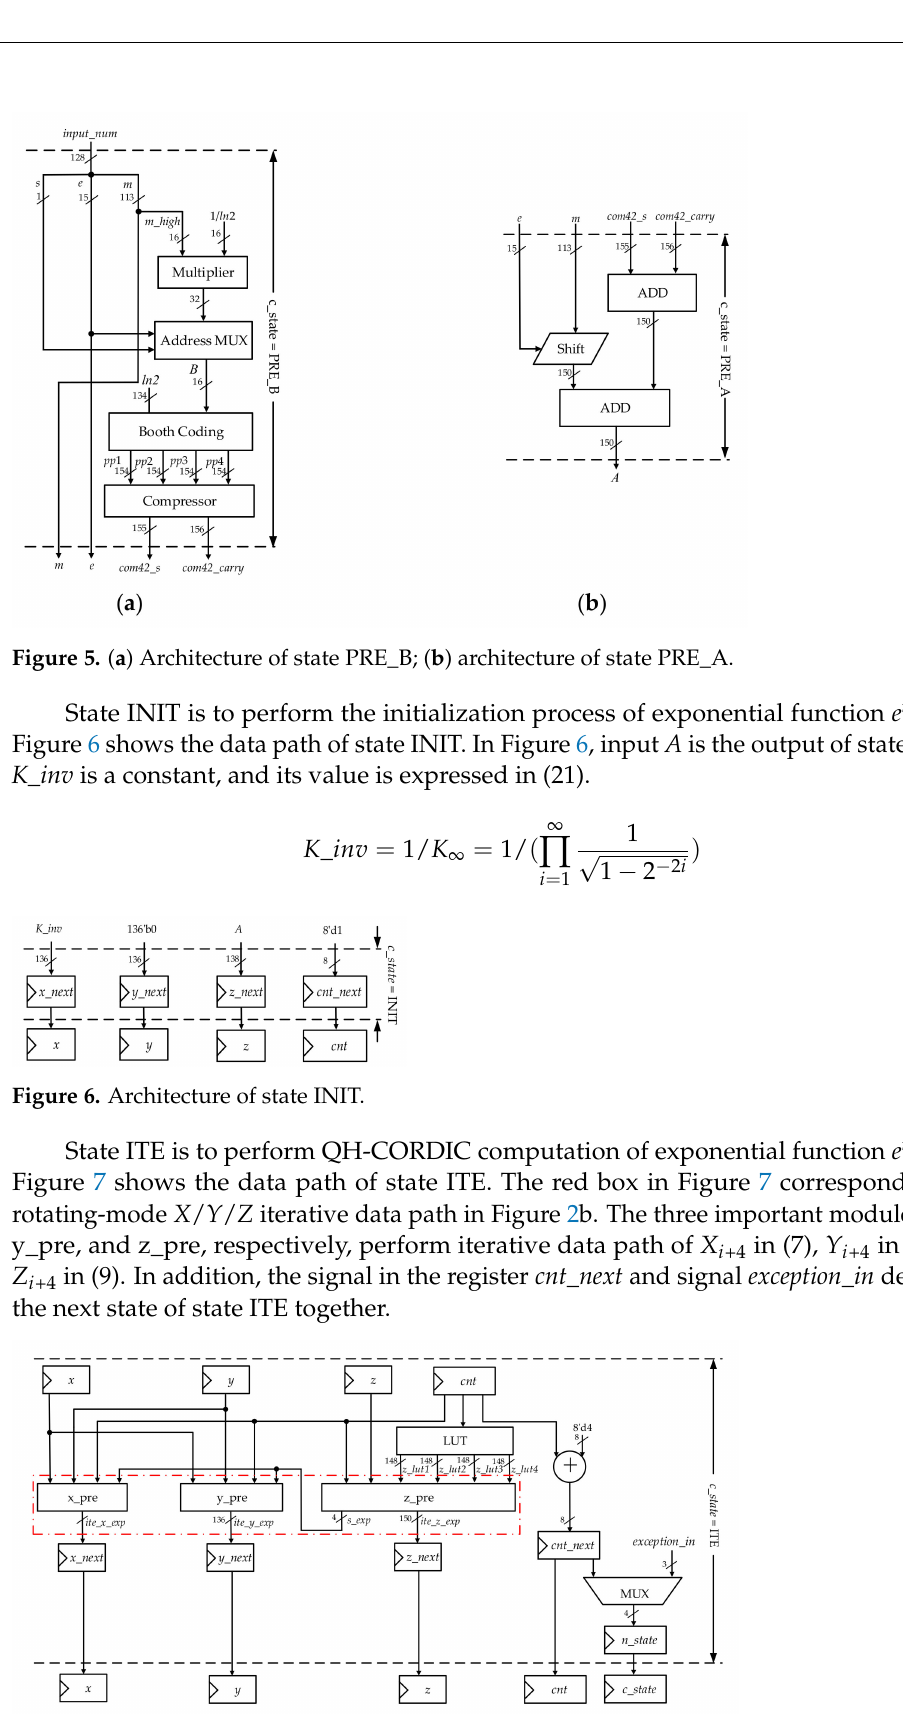
Figure 7. Architecture of state